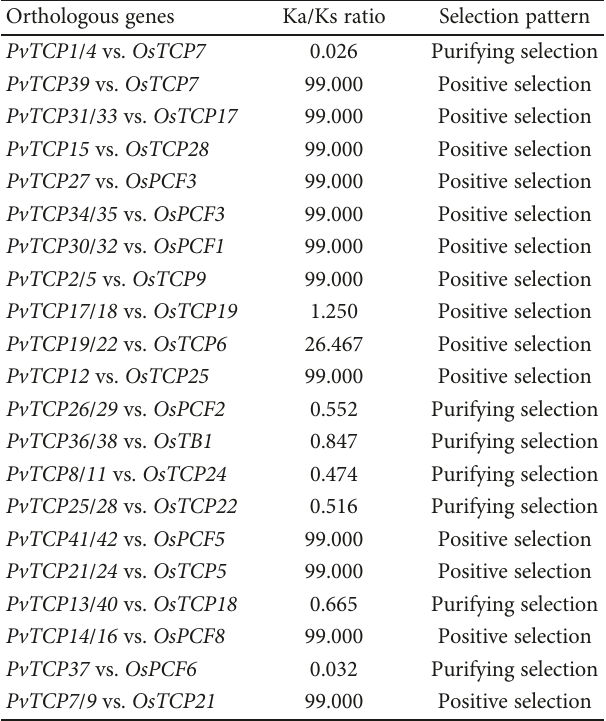
Table 2: Ka/Ks ratio of TCP orthologous genes between switchgrass and